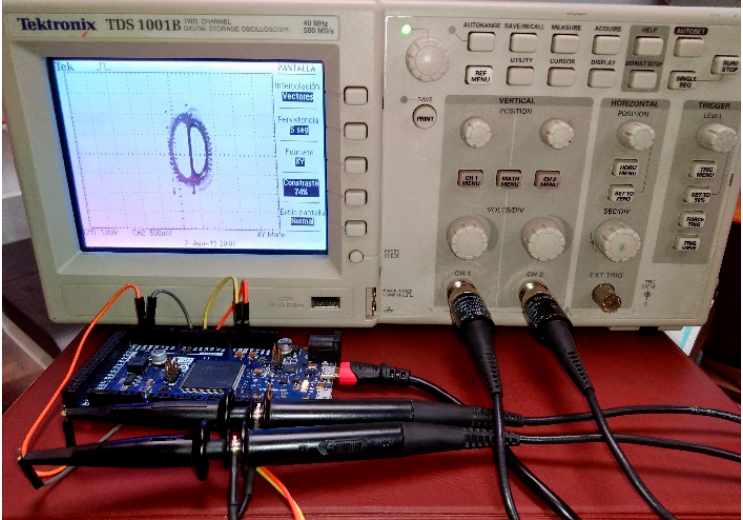
Figure 6. Hardware of microcontroller based active controller implementation.